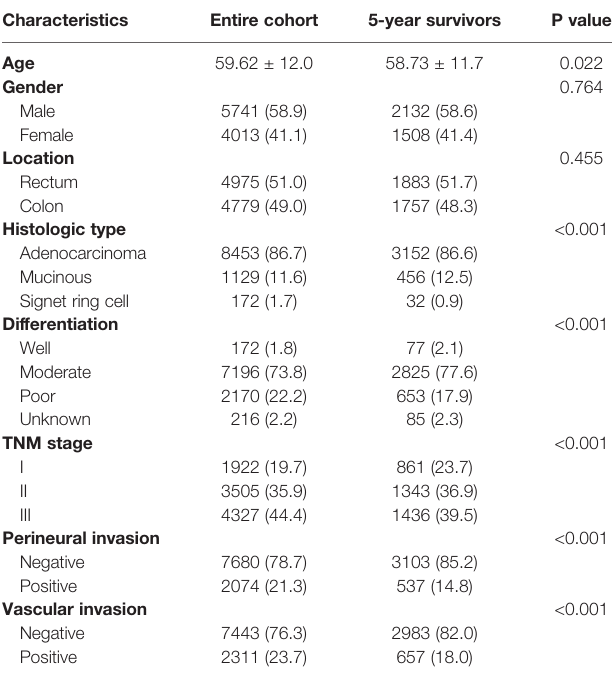
TABLE 1 | Characteristics of stage I-III CRC patients who received radical surgery in FUSCC between 2008 and 2018 (N = 9754) and patients who survived 5 years following surgery (n =